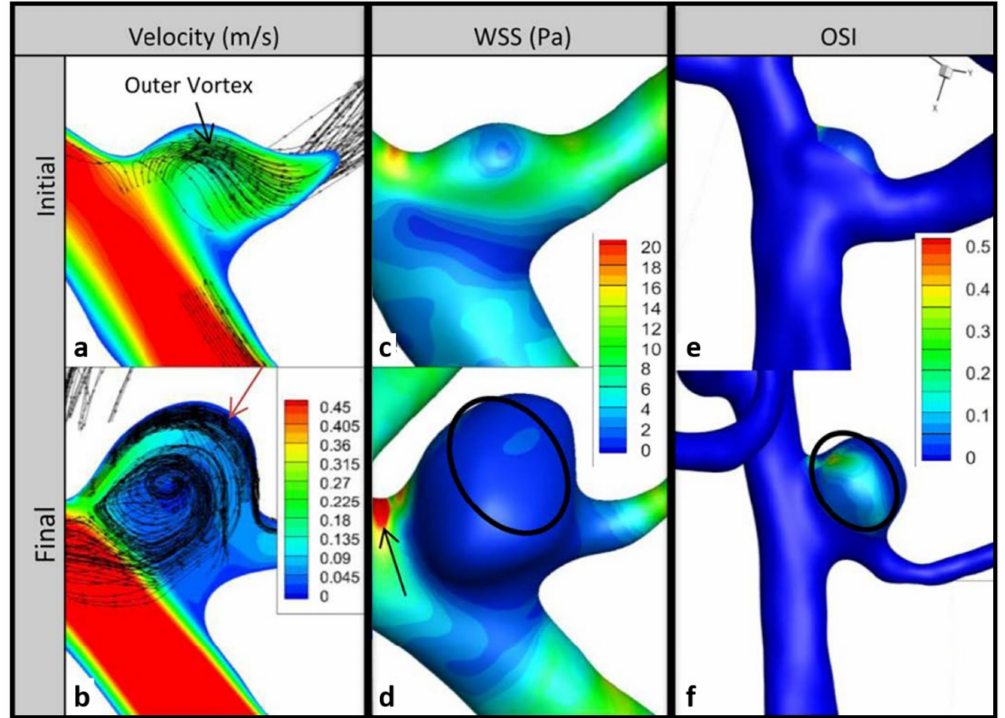
Figure 9. Impingement data planes and wall contours for P4. Velocity: changes in velocity between initial ( a ) and follow-up ( b ); red arrow shows region of low velocity near higher velocity where growth occurred. WSS: changes in WSS between initial ( c ) and follow-up ( d ); black arrow shows change in WSS near the impingement region and circle shows region with significant decrease in WSS. OSI: changes in OSI between initial ( e ) and follow-up ( f ); circle shows increase in area of elevated